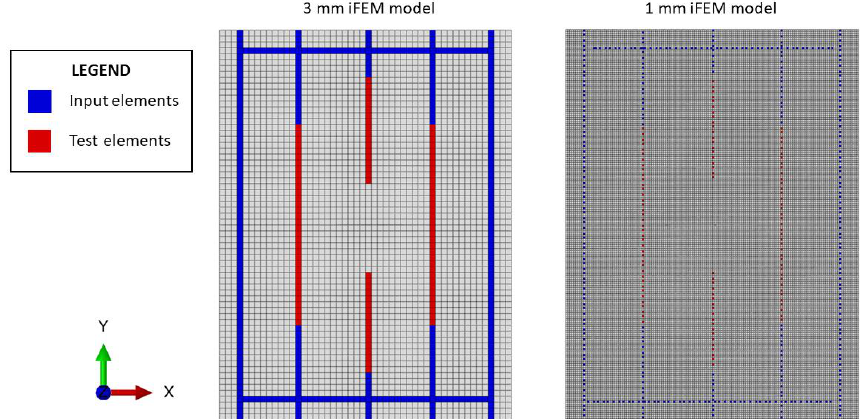
Figure 11. Mesh discretization (3 mm and 1 mm meshes) with input and test sensor networks.